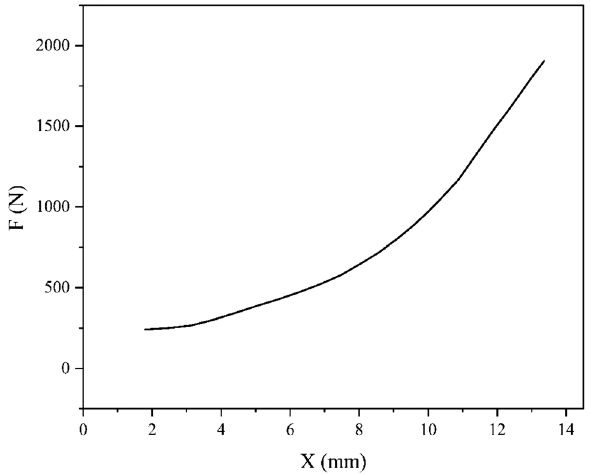
Fig. 2 Air column bags force–deformation